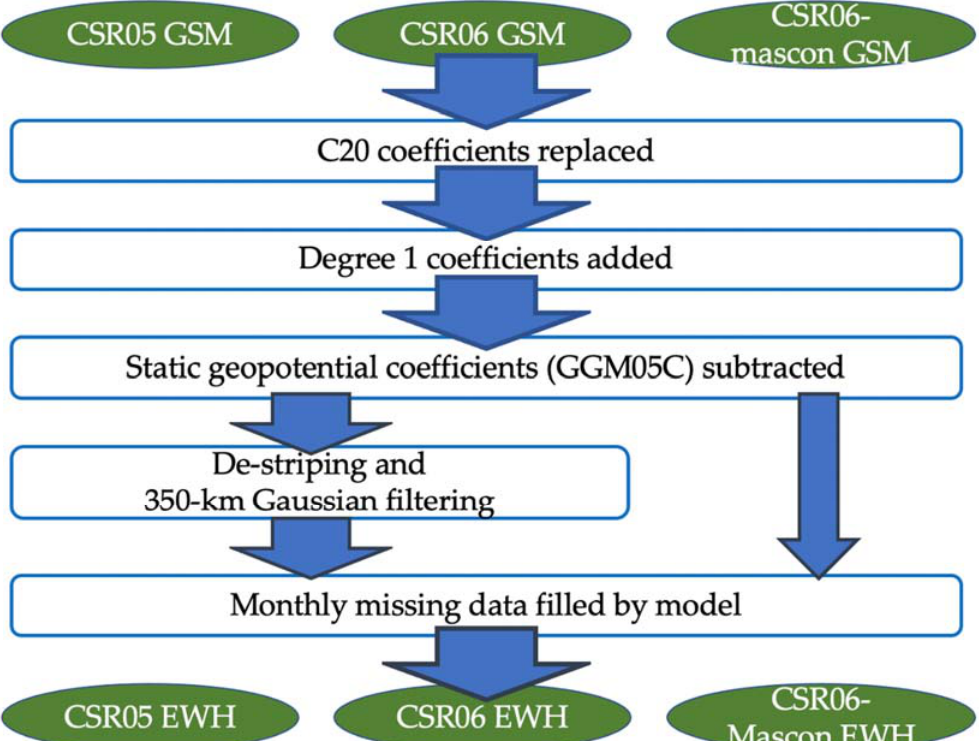
Figure 2. A flow chart of GRACE further processes from GSM to EWH on CSR05, CSR06 and CSR06-mascon. GSM, GRACE geopotential coefficients after priori models corrections; GGM05C, a combination global gravity model; EWH, equivalent water height.